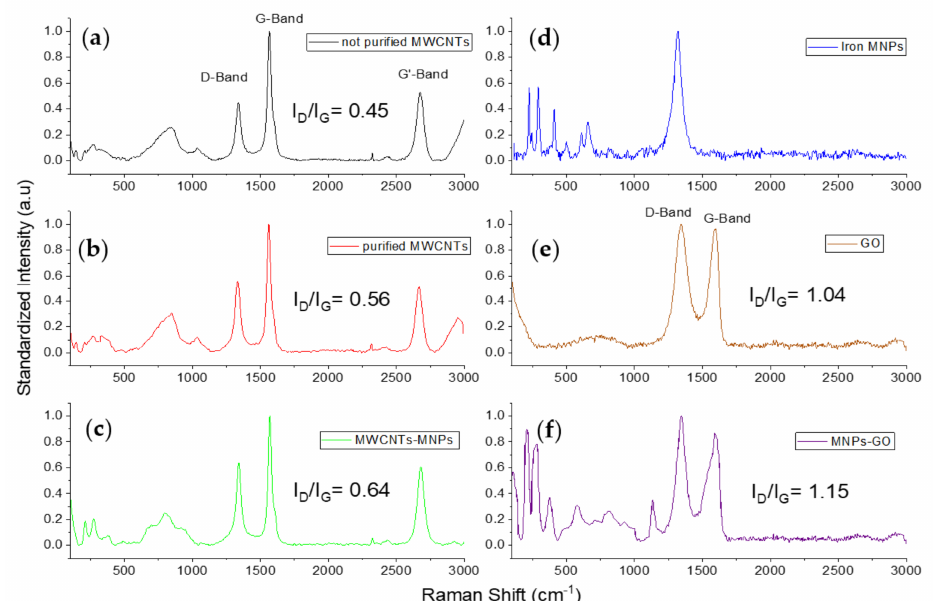
Figure 2. Raman Spectra: ( a ) non-purified MWCNTs, ( b ) purified MWCNTs, ( c ) MNPs-MWCNTs; ( d ) Fe-MNPs; ( e ) GO; ( f ) MNPs-GO; E l á ser = 2.33 eV, λ = 532